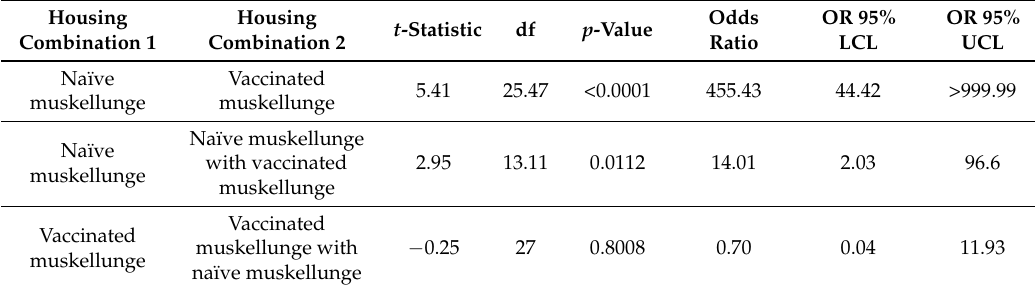
Table 2. Pairwise comparison of cumulative mortality. Results from pairwise comparisons of cumulative mortality between tank treatments. The t -statistic, degrees of freedom, and p -value are included for each comparison. The odds ratio (OR) and upper and lower 95% confidence limit for the ORs are also shown. The ORs measure how much more likely fish in housing combination 1 would experience mortality versus individuals in housing combination 2. ORs were calculated using the predicted marginal mean cumulative mortalities from the fitted model.